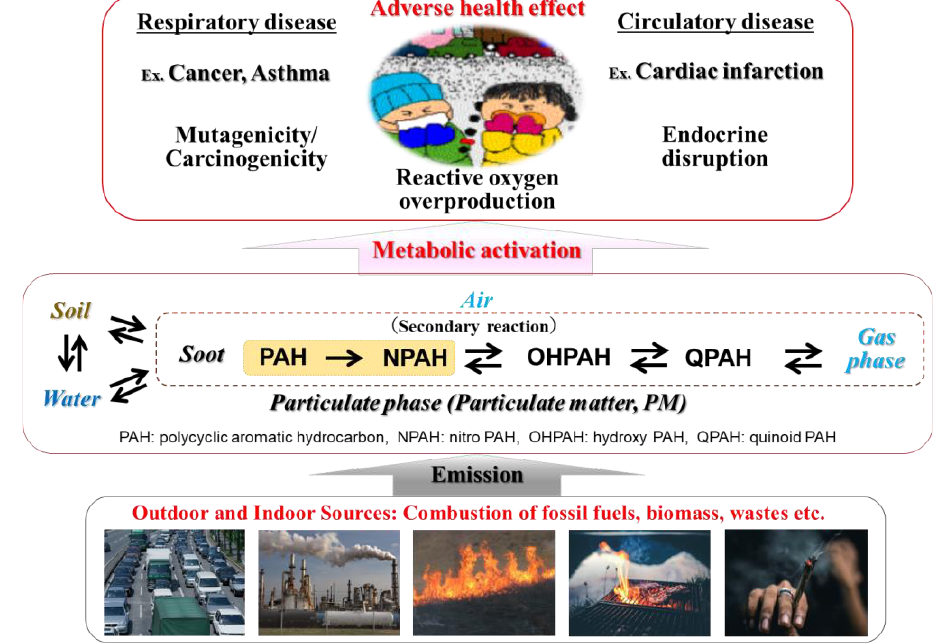
Figure 1. Polycyclic Aromatic Hydrocarbons and Derivatives: Emission and Adverse Health Effects.